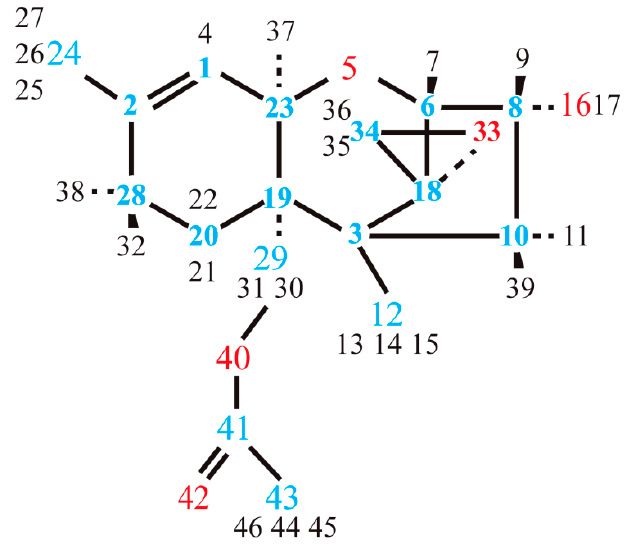
Figure 3. Atomic labels for the 3-deacetylcalonectrin molecule (blue, red and black numbers are representation of carbon, oxygen and hydrogen atoms, respectively).